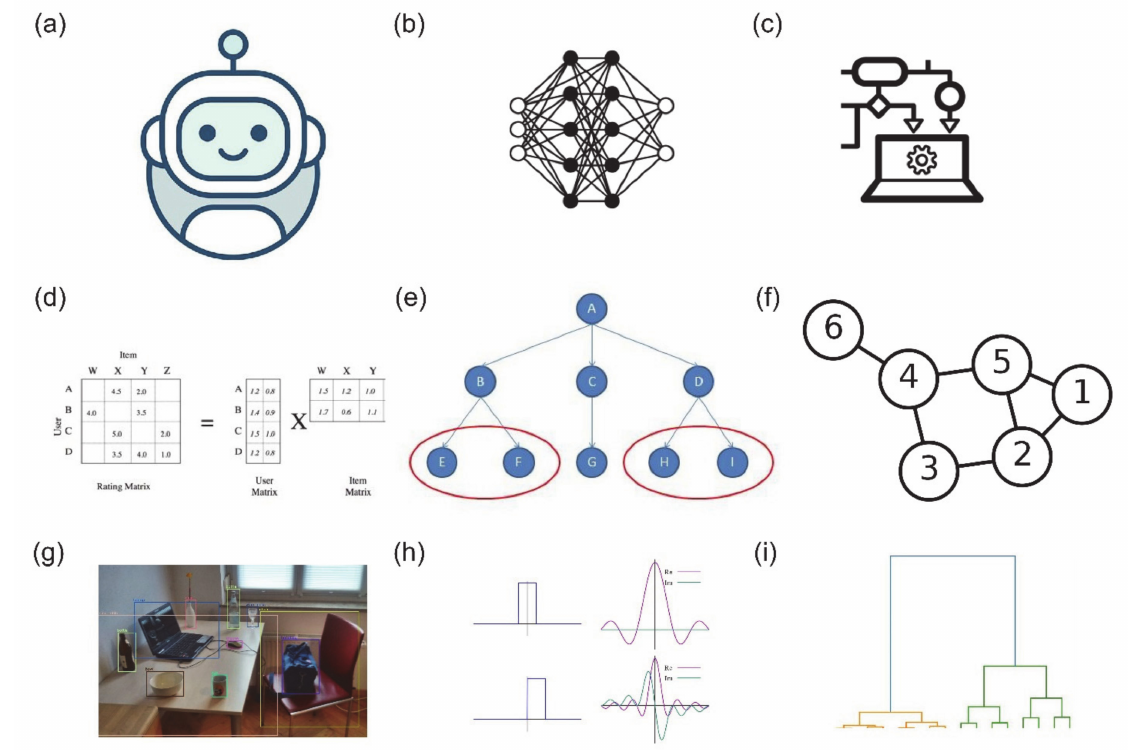
Figure 1. Visualisation of the broad categories of strategies used for predicting lncRNA-protein interactions. ( a ) Machine learning, ( b ) deep learning, ( c ) ensemble learning, ( d ) matrix factorisation, ( e ) similarity network analysis, ( f ) graph theory, ( g ) segmentation, ( h ) Fourier transform (in lncRNA-protein molecular docking simulations) and ( i ) hierarchical clustering. Training data are commonly higher-level features (e.g., structure, orientation) of lncRNA and proteins as well as the sequences recoded into tensors of varying